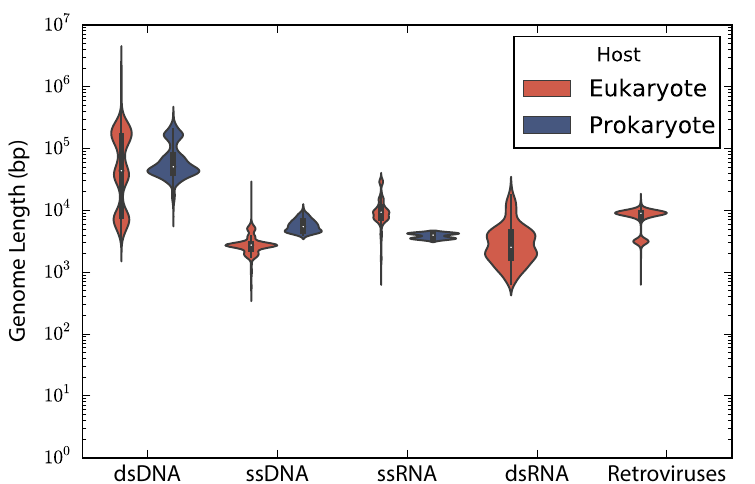
Figure 1. Genome length distribution. Violin plots show the genome length distribution of the non- redundant viruses used in the study. Viruses are grouped by the type of genetic material and type of host. The inner boxplot shows the median (white circle) and interquartile range (whisker plots). The set of 14,057 non-redundant genomes code for a total of 442,007 proteins, where we observe that the number of genes is directly proportional to the length of the genome.